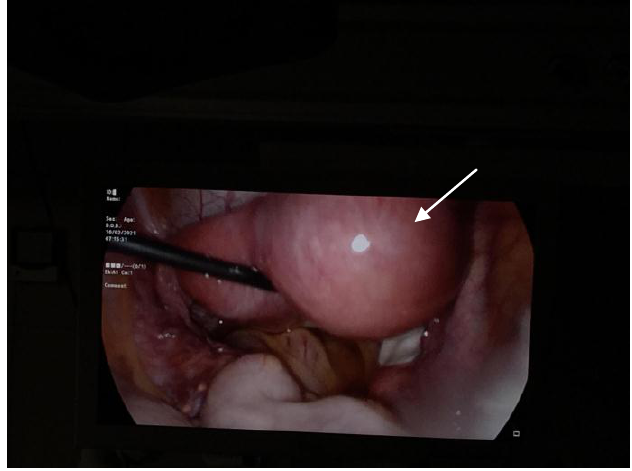
Figure 2 : the functional rudimentary non-communicating uterus under